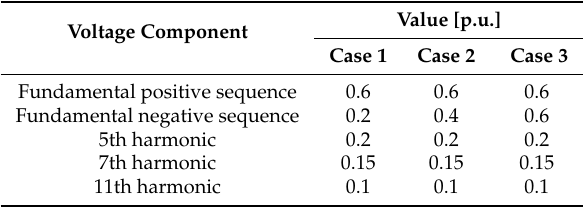
Table 1. Parameters of the grid voltage during the